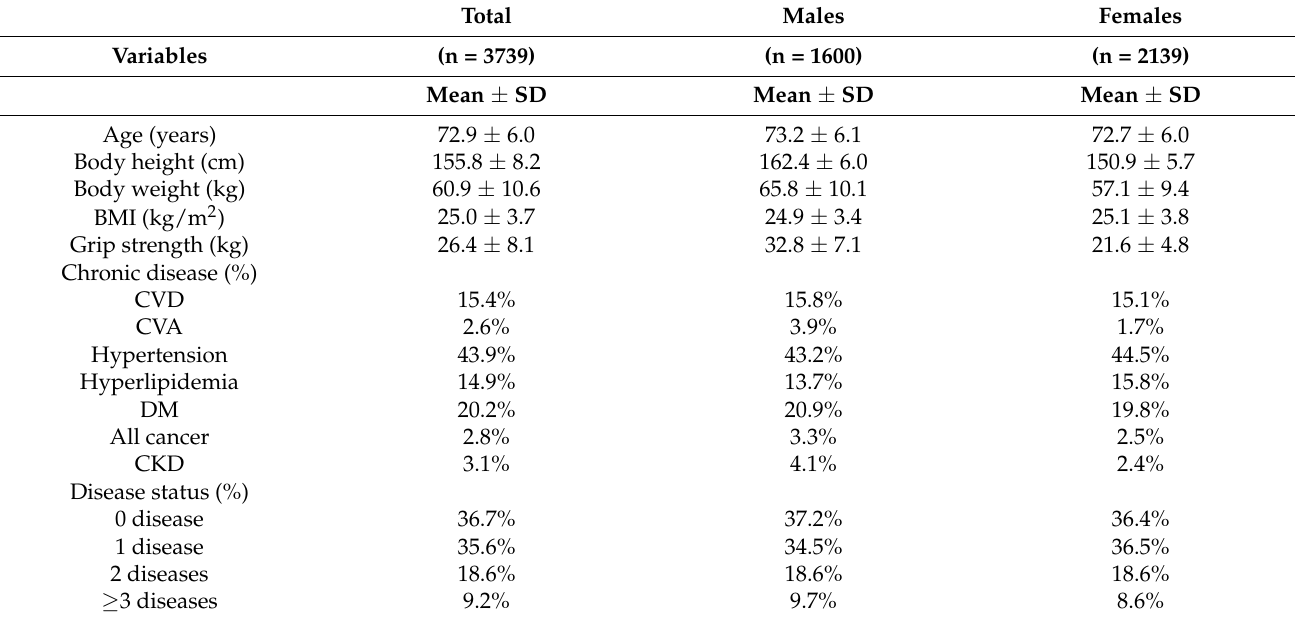
Table 1. Distributions (mean ± SD) of general characteristics and chronic disease status among study population (n = 3739).